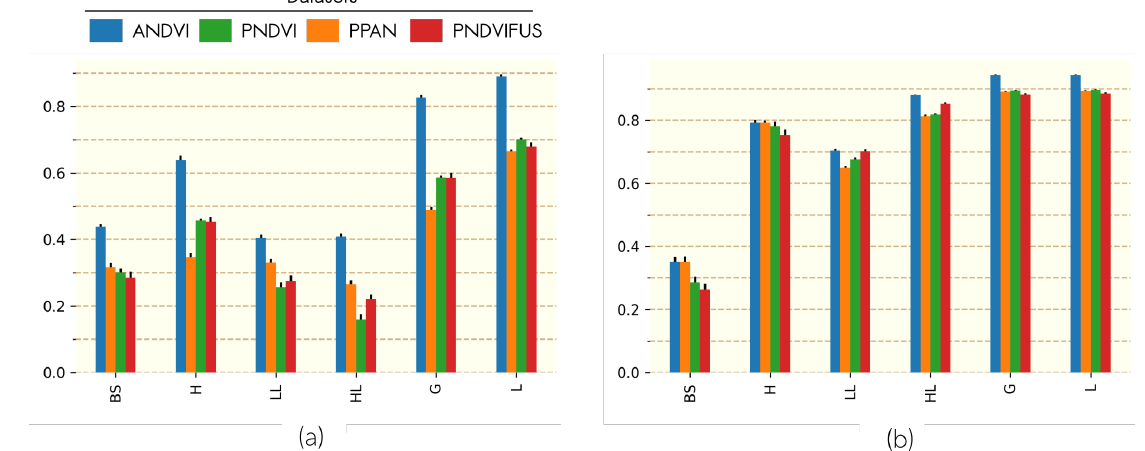
Figure 3. Mean of coefficients of determination over 30 iterations of regression models predicting LSI ( a ) and PLAND ( b ) for each stratum and combination of strata with indices computed from different band. Error bars represent the standard deviation of coefficients of determination over the 30